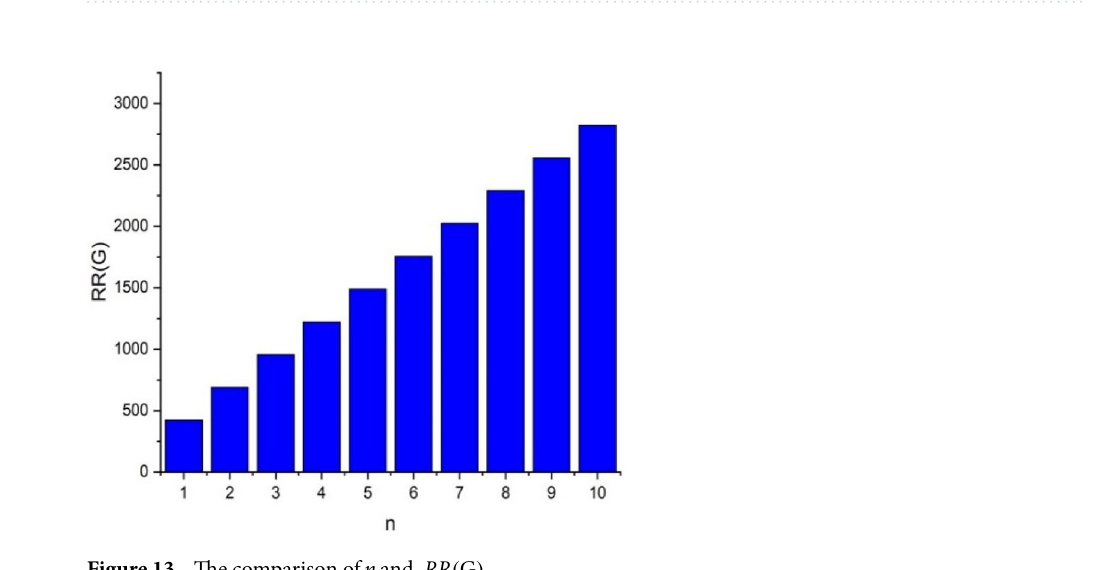
Figure 13. The comparison of n and . RR ( G )